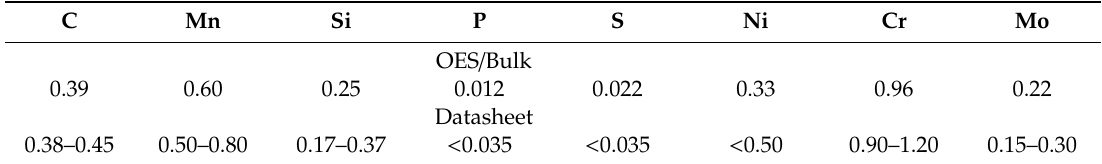
Table 3. Chemical composition of steel equivalent 42CrMo4 (i.e., CSN 41 5142) verified by Tasman Q4 Bruker (wt.%).